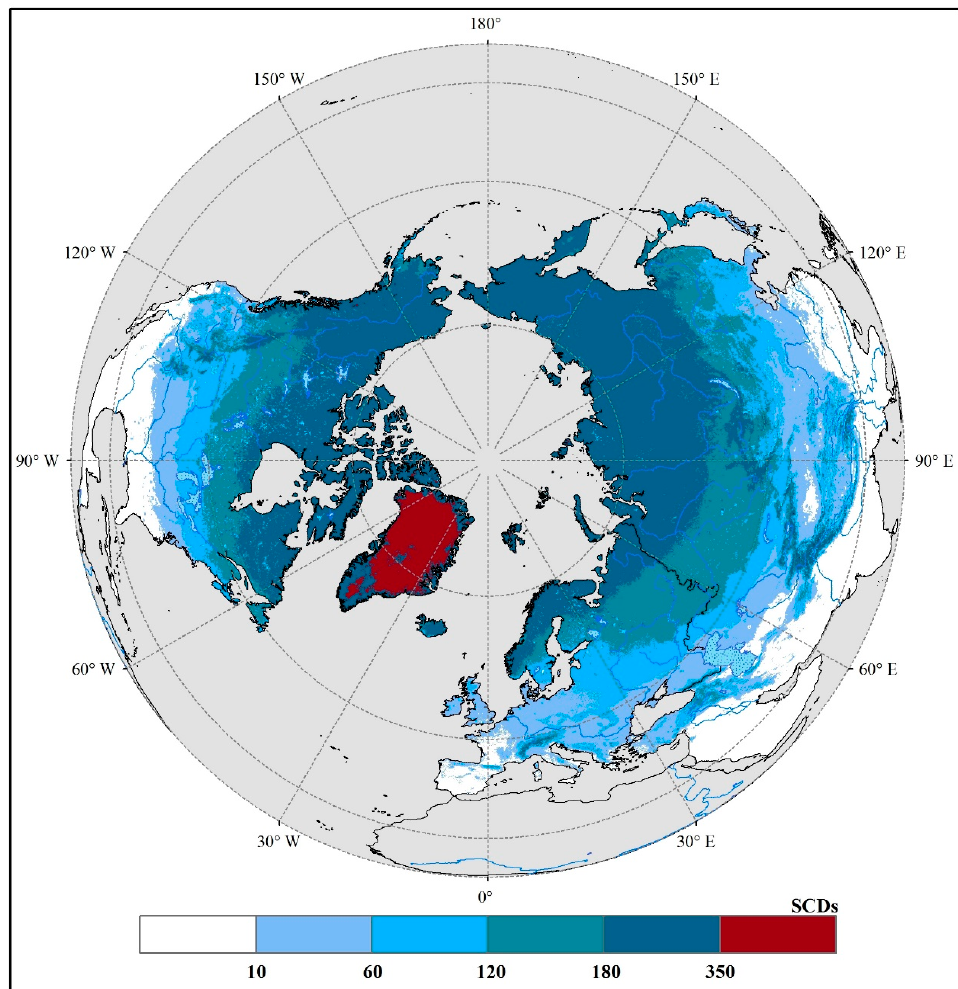
Figure 8. Spatial distribution of the average annual snow-covered days (SCD) during the period 2000–2015 in the Northern Hemisphere.